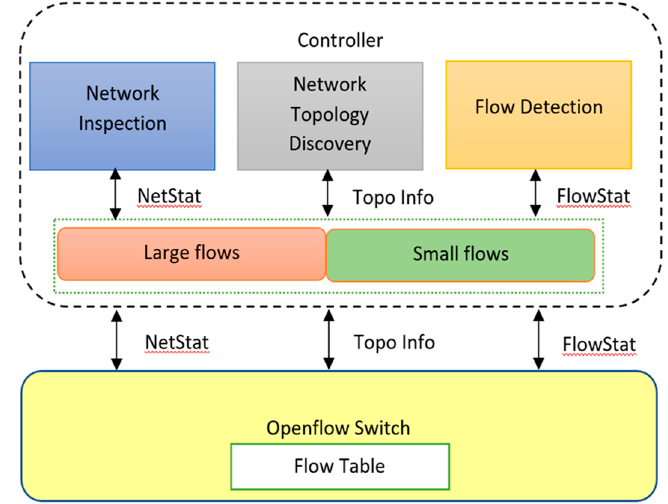
Figure 7. Flow-based scheduling.